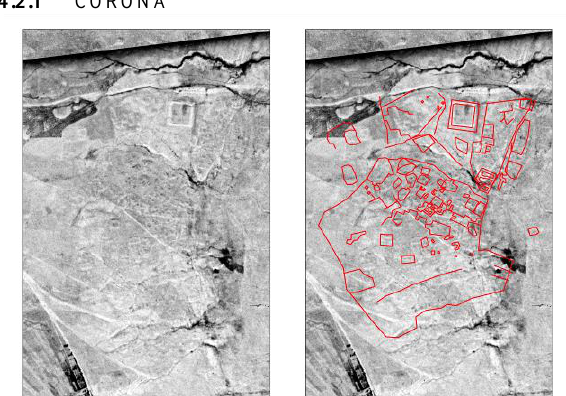
Figure 10 - Makhmúr al-Qadíma, the qasr from northeast